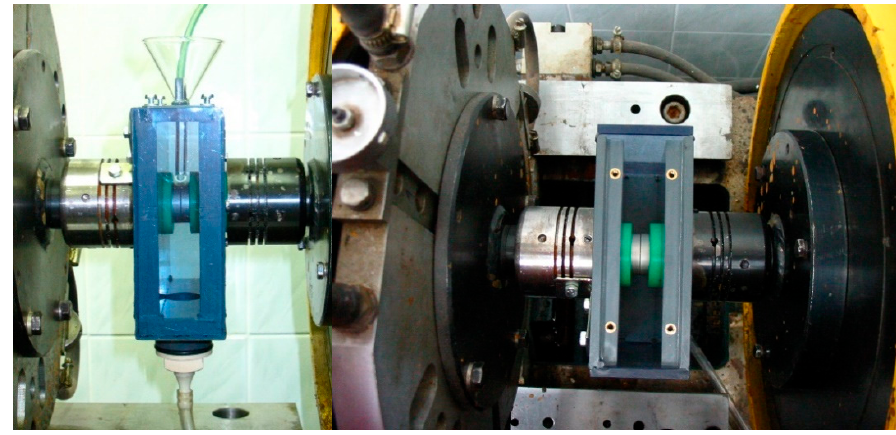
Figure 4. Testing chamber view.